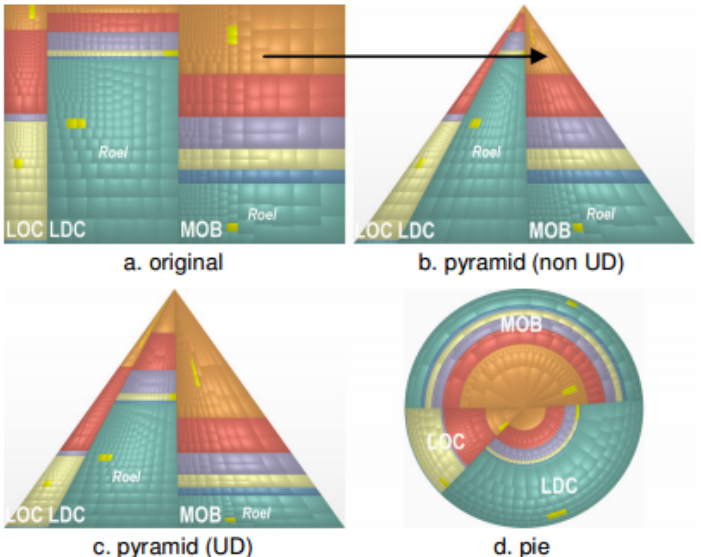
Figure 4. The transformation of the treemaps into other shapes: ( a ) the original treemap; ( b ) the original transformed into a pyramid but without density uniformity; ( c ) the modified version of ( b ) now adjusted to show uniform density; and ( d ) the transformation of the original into a pie chart. Image courtesy of Vliegen et al.